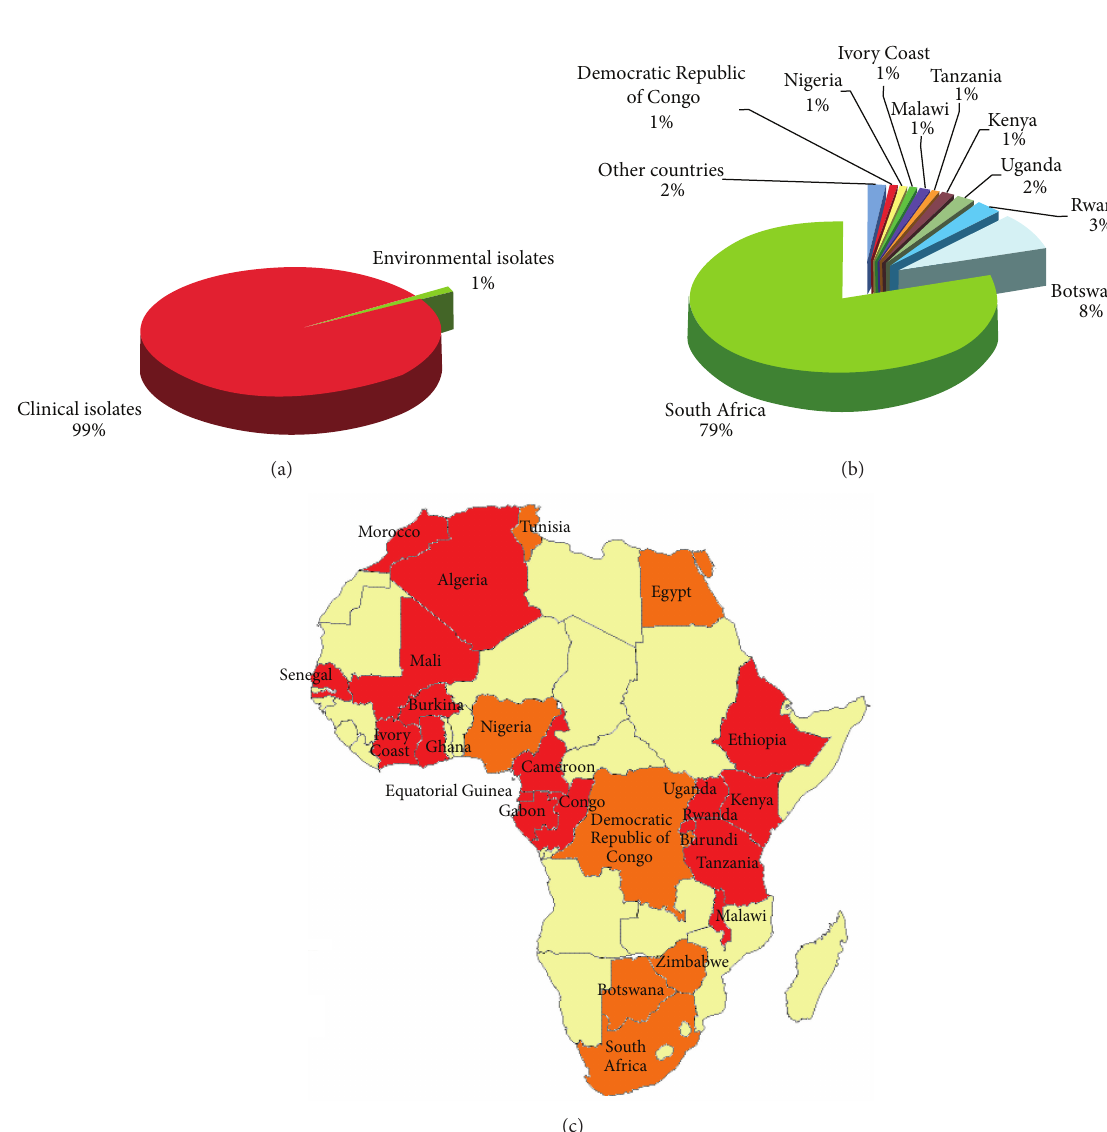
F 5: Percentage of Cryptococcus neoformans and Cryptococcus gattii isolates from clinical ( sources (a). Distribution of Cryptococcus neoformans and Cryptococcus gattii isolates in the different African countries (b). Map of the geographical distribution of the Cryptococcus neoformans and Cryptococcus gattii isolates in Africa (c). Clinical isolates were reported from red-colored countries, whereas both clinical and environmental isolates were reported from orange-colored